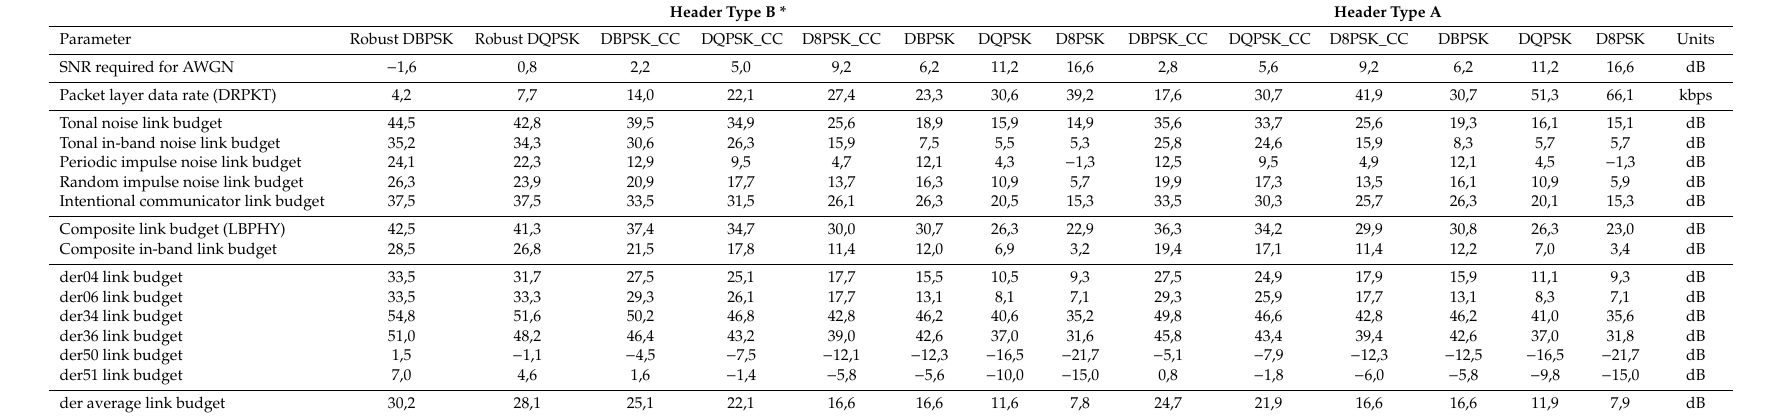
Table 6. Absolute results with Reed–Solomon encoding for PRIME 1.3.6 and 1.4 (including the spline equalizer).